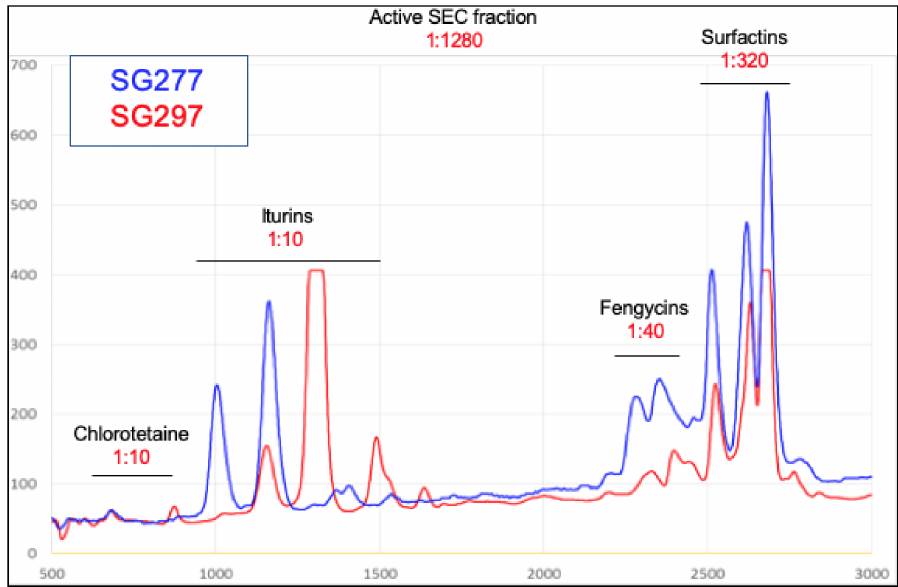
Figure 3. RP-HPLC separation and MALDI-TOF analysis of active components. RP-HPLC separation of the active SEC fraction from SG277 and SG297 using a gradient of 65–95% MeOH (+0.1% acetic acid). Peaks were analysed using MALDI-TOF and compounds are indicated in the figure. Initial inhibitory activity of the SEC fraction was 1:1280 and those in RP-HPLC fractions are indicated in red